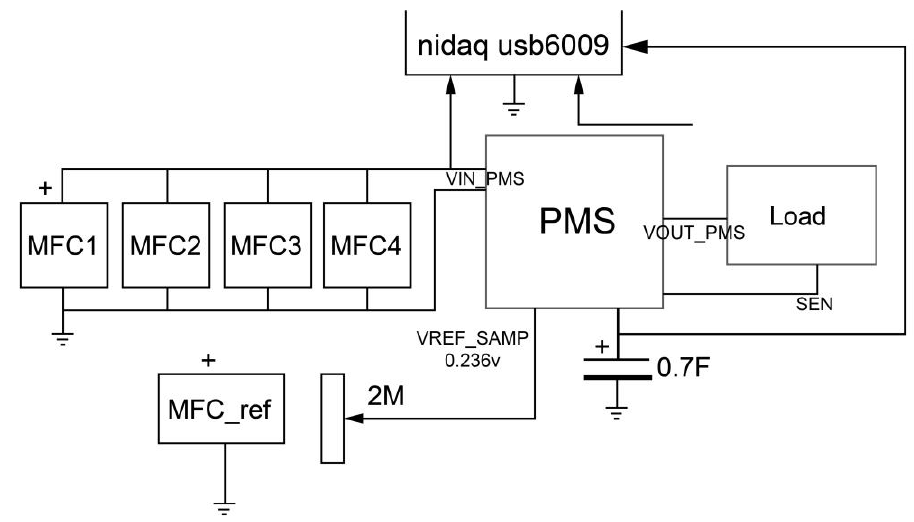
Figure 4. Capacitor and PMS input and output voltage test.